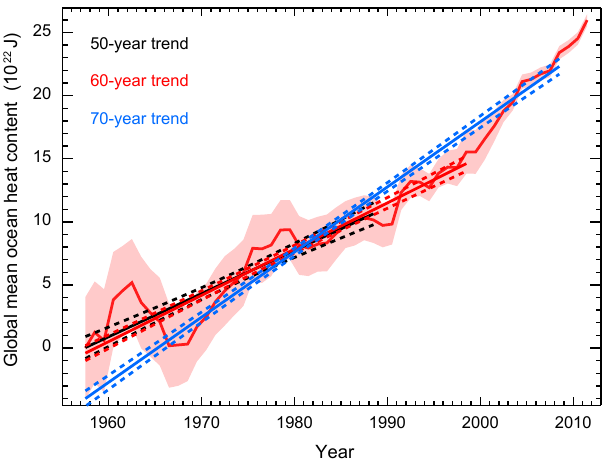
Figure 7. Decadal mean temperature anomaly time series derived from the HadCRUT4, NOAA MLOST, BEST, and GISTEMP 250 datasets. Time series are for the four equal-area zonal bands span- ning (a) 30–90 ◦ N, (b) 0–30 ◦ N, (c) 0–30 ◦ S, (d) and 30–90 ◦ S. Temperatures are plotted as anomalies with respect to the 1906– 1995 base period at the midpoint of each decade.